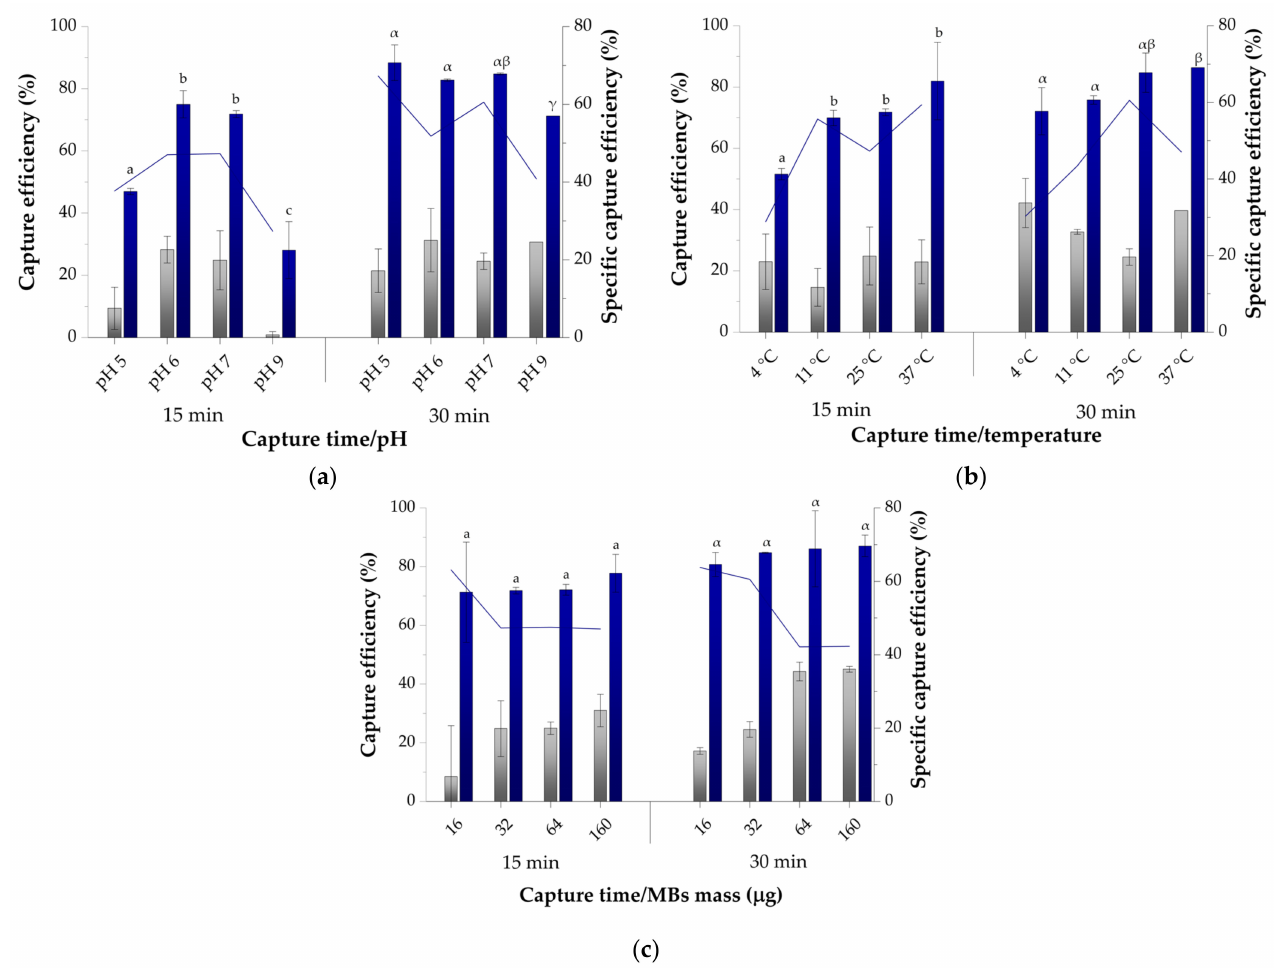
Figure 5. Phagomagnetic separation protocol optimization resorting to molybdophosphate method. The capture efficiency (%) (columns) and specific capture efficiency (%) (solid line) of P100–MBs ( (cid:4) ) and blank–MBs ( (cid:4) ) for the separation of L. monocytogenes (10 3 CFU mL − 1 ). Each variable was optimized following fixed assay conditions: ( a ) 32 µ g MBs, 25 ◦ C; ( b ) 32 µ g MBs, pH 7; ( c ) 25 ◦ C, pH 7. Each error bar was estimated as the standard deviation of three independent